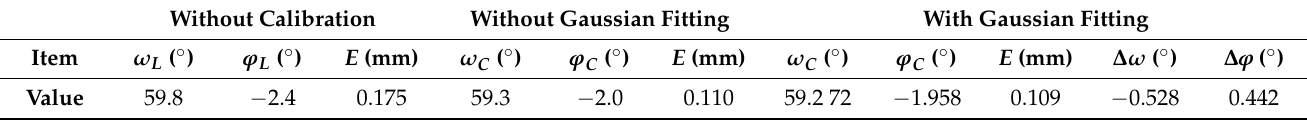
Table 5. Calibration results of eccentric angles and camera orientation to the calibration